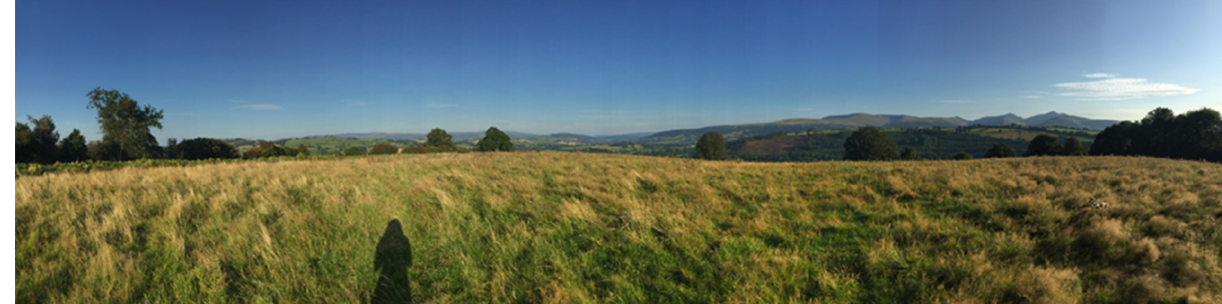
Figure 1. A picture of the space outside of Brecon in Slwch Tump, which is described as the setting of St. Eluned’s shrine.